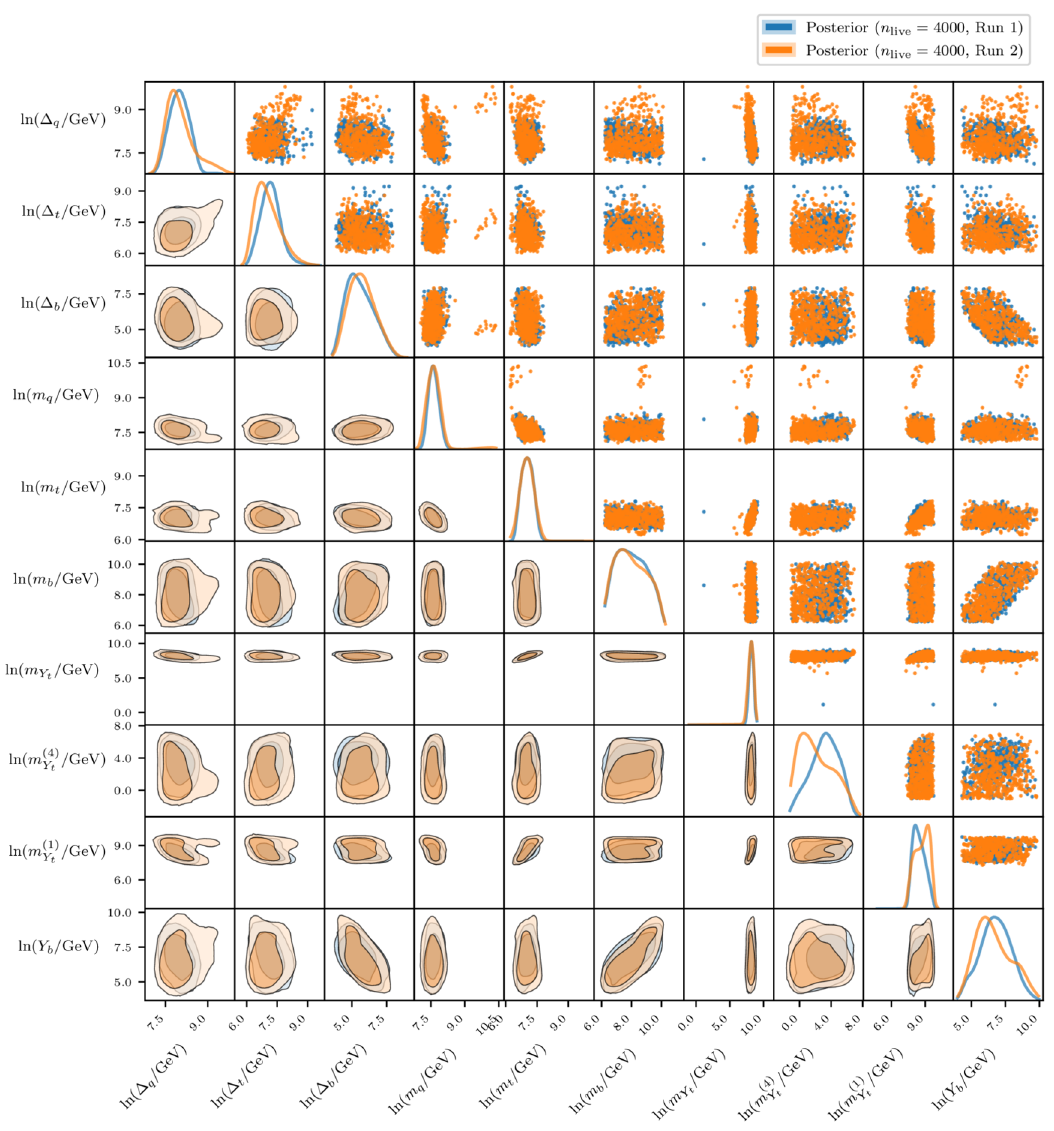
Figure 22. 1D and 2D marginalised posteriors for the fermion sector parameters in the M4DCHM 14 − 14 − 10 found in two different runs with 4000 live